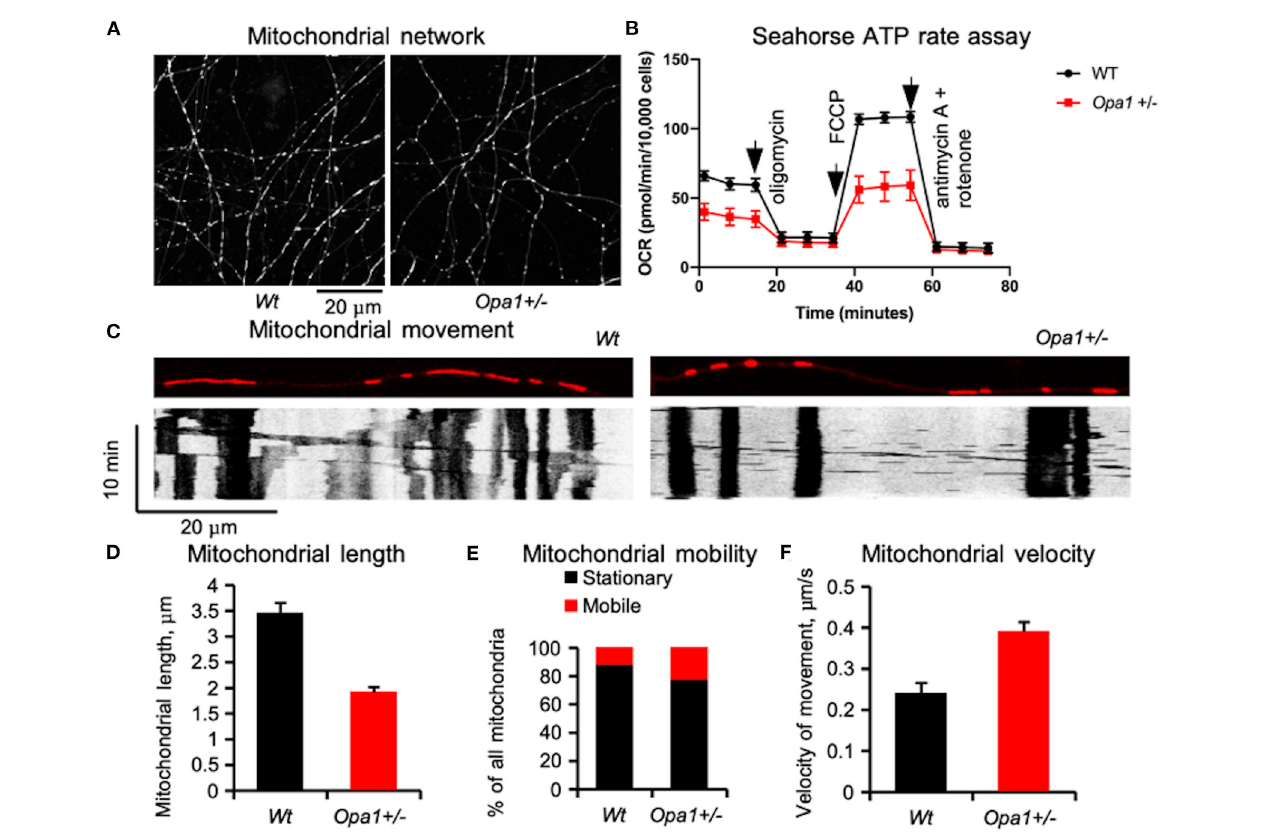
FIGURE 1 | Mitochondrial network in primary retinal ganglion cells (RGCs) in mutant mice (B6;C3- Opa1 Q 285 STOP , Opa1 + / − ) [adapted from Sun et al. (27)]. (A) Tubular mitochondrial network in control and mutant mice labeled in live culture by MitoTracker ® Red and recorded by time-lapse imaging on the 8th day in vitro . (B) Mitochondrial network functionality assessed by Seahorse assay. (C) Mitochondrial movement in RGC dendrites is illustrated by automatically generated kymographs using FIJI software. (D) Average length of a single mitochondrial segment. (E) Distribution of the mitochondrion population classified as stationary and motile. (F) Velocities of mitochondrial movement. The increased mitochondrial mobility and velocity may be a compensatory mechanism for a poor cellular distribution network. The data were obtained from 1280 mitochondria in 91 processes of wild-type RGCs and 1205 mitochondria in 92 processes of Opa1 + /- RGCs.